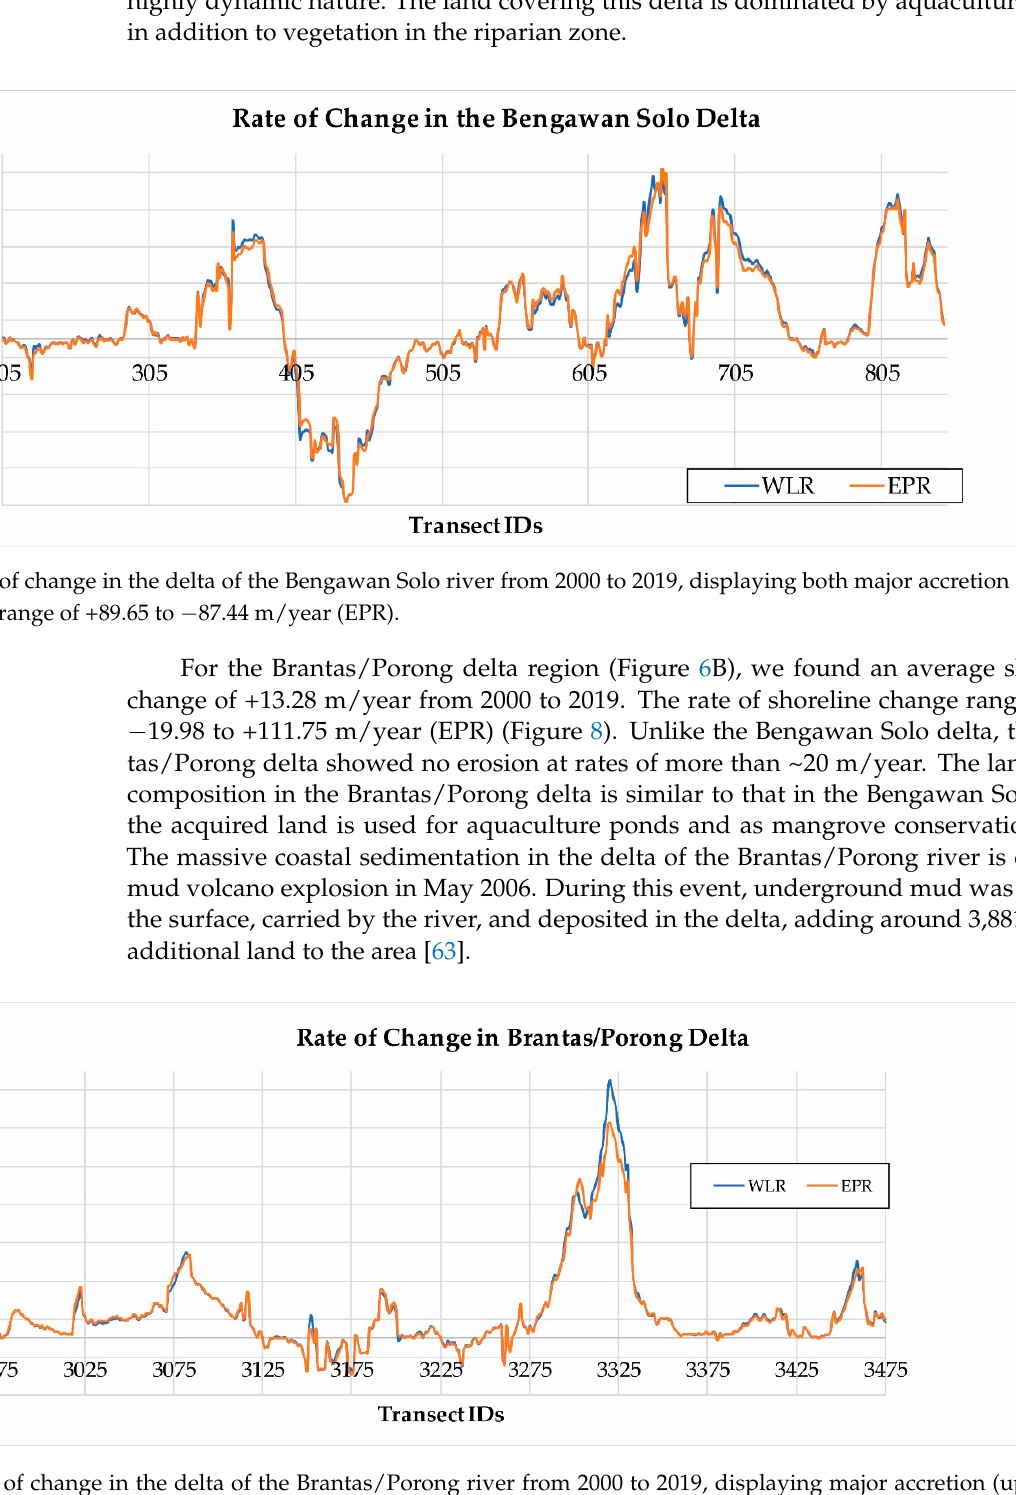
Figure 8. Rate of change in the delta of the Brantas/Porong river from 2000 to 2019, displaying major accretion (up to +111.75 m/year) and moderate erosion (up to − 18.98 m/year) (EPR).